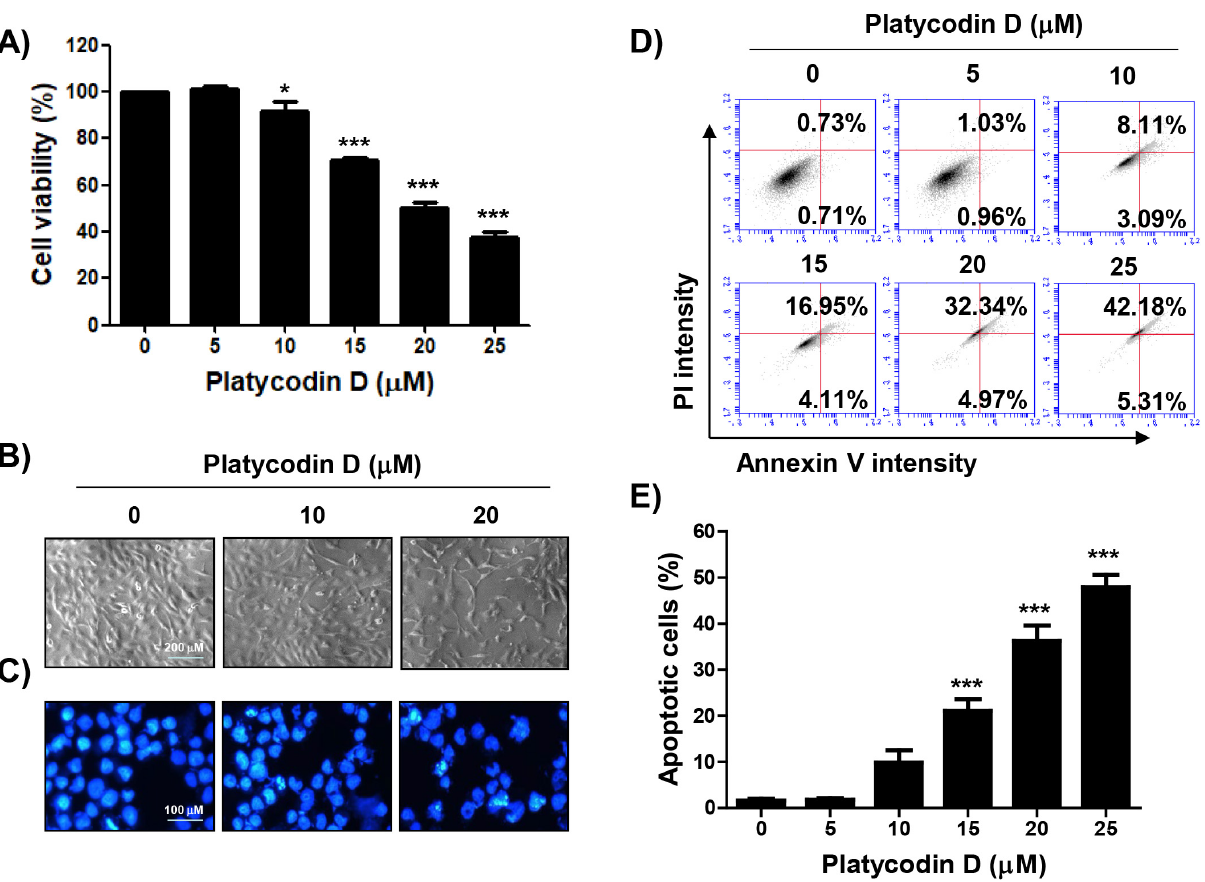
Fig. 1. Reduction of cell viability and induction of apoptosis by PD in PC3 cells. PC3 cells were treated with the indicated concen- trations of PD for 48 h. (A) After treatment with PD, cell viability was measured by the MTT assay. (B) Morphological changes after treatment with PD were captured on a phase-contrast microscope. (C) The nuclear morphological changes were observed using DAPI staining, and then photographed under a fluorescence microscope. (D and E) The fixed cells were stained with annexin V/PI for flow cytometry analysis. (D) Representative flow cytometry plots are presented. (E) The populations of apoptotic cells were determined by expressing the numbers of annexin V + cells. The data are presented as the mean ± SD of three independent experiments ( ∗∗ P < 0.01 and ∗∗∗ P < 0.001 compared to untreated